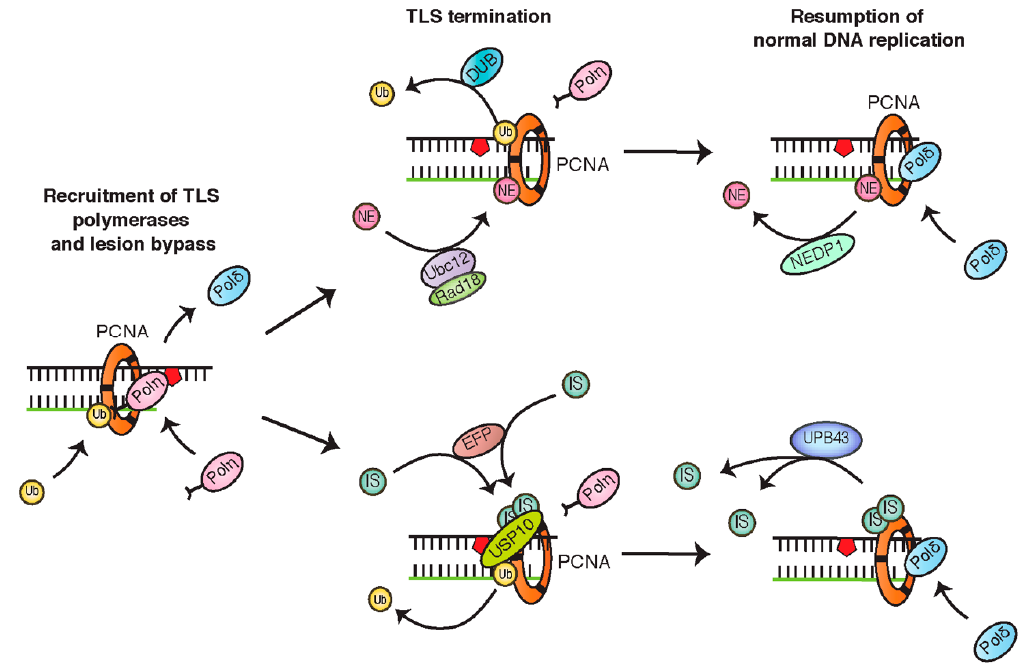
Figure 6. Schematics indicating the negative regulation of PCNA monoubiquitination by NEDDylation and ISGylation. Both modifications promote the deubiquitination of PCNA and translesion synthesis (TLS) termination.